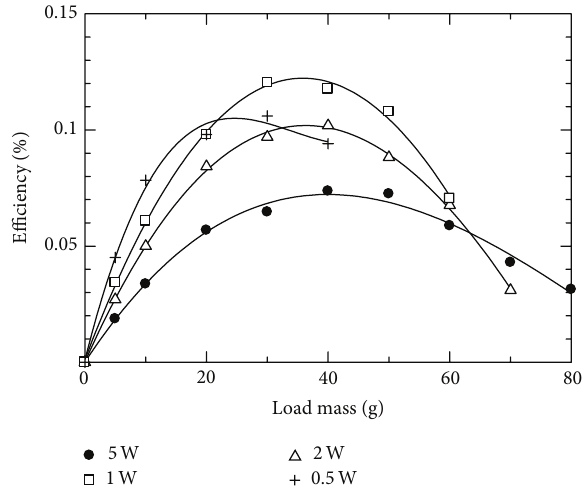
Figure 9: Relationship between load mass and efficiency.